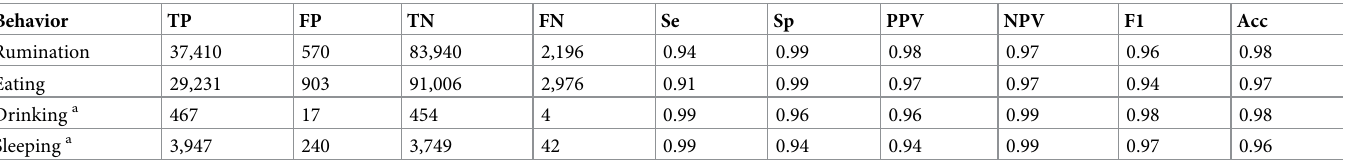
Table 6. Random forest algorithms (RF 70/30) for different